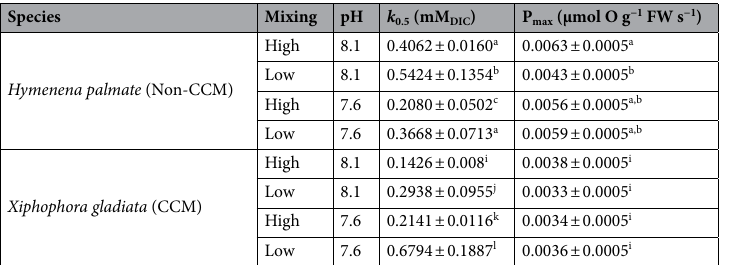
Table 2. Carbon uptake efficiency (k 0.5 ) and photosynthetic maximum (P max ) of a non-CCM red ( Hymenena palmata ) and CCM brown species ( Xiphophora gladiata ) under high- and low-mixing conditions and high (8.1) and low (7.6) pH. Values represent mean ± SE, n = 4. Simultaneous t tests were used to test for significant differences between the water motion and pH treatments within each species, with a p-value < 0.05 indicating a significant difference. Different lowercase letters indicate significant differences between values, while the same letter indicates there is no significant difference.